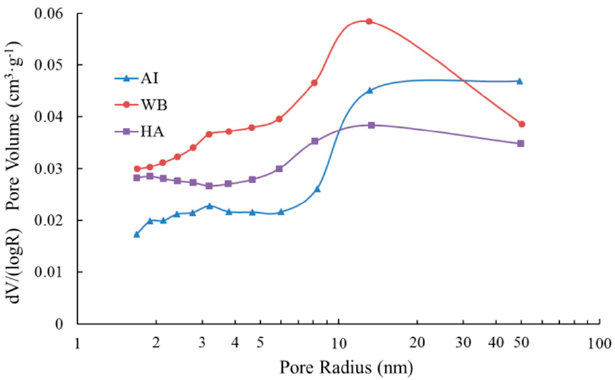
Figure 15. Pore radius distribution of the carbonation layers in different exposed environments. The pore structure parameters of the carbonation layers in different environments that were determined by the nitrogen adsorption method are shown in Table 6. The specific surface area that was calculated from N 2 adsorption data using the multipoint BET model ranges from 23.6899 to 35.3504 m 2 /g, and the specific surface area of group HA is the largest, at about 35.3504 m 2 /g, while that of group AI is the smallest, at about 23.6899 m 2 /g. The specific surface area of group HA is 1.5 times that of group AI, and it is only 3.058 m 2 /g larger than that of group WB. The total pore volumes (cm 3 /g) were found to be 0.0671 for group AI, 0.0787 for group WB, and 0.0681 for group HA (Table 6). The average pore